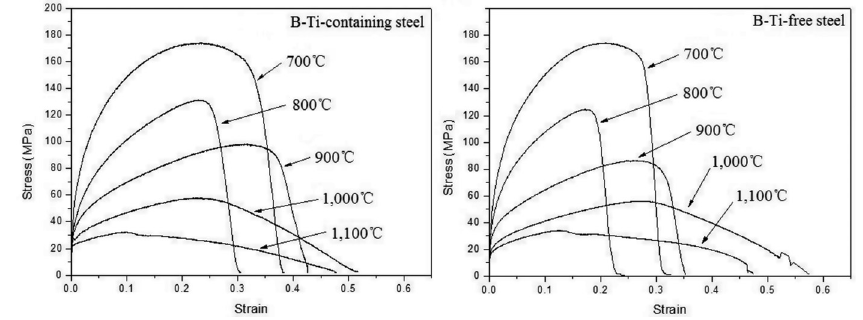
Figure 5: Strain – stress curves of the steel samples A and B from 700°C to 1,100°C.